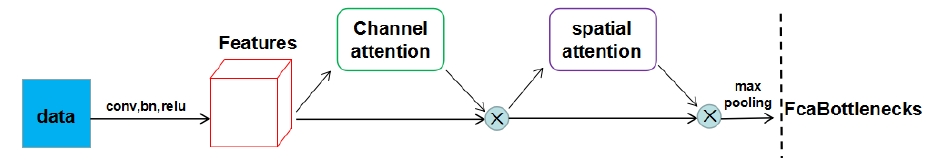
Figure 7. The overall structure of the method in this paper.